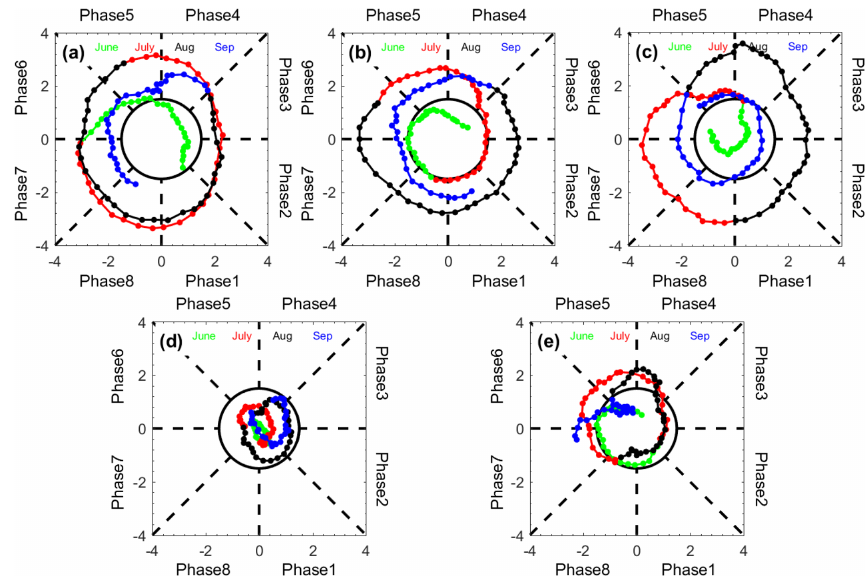
Figure 9. 2-D phase space diagrams for the NLSA MISO indices in years: (a) 2007, (b) 2008, (c) 2009, (d) 2010, and (e) 2011. A coun- terclockwise propagation from Phase 1 represents MISO’s northward propagation. The circle centered at the origin has radius equal to 1.5, which is the threshold for identification of significant MISO